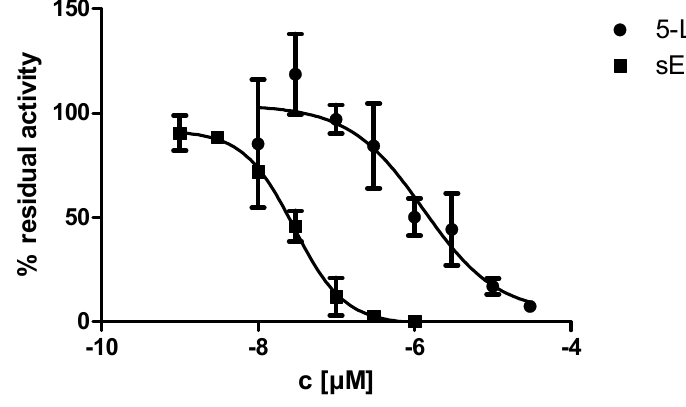
Figure 1. Inhibitory effect of KM55 on recombinant enzymes.